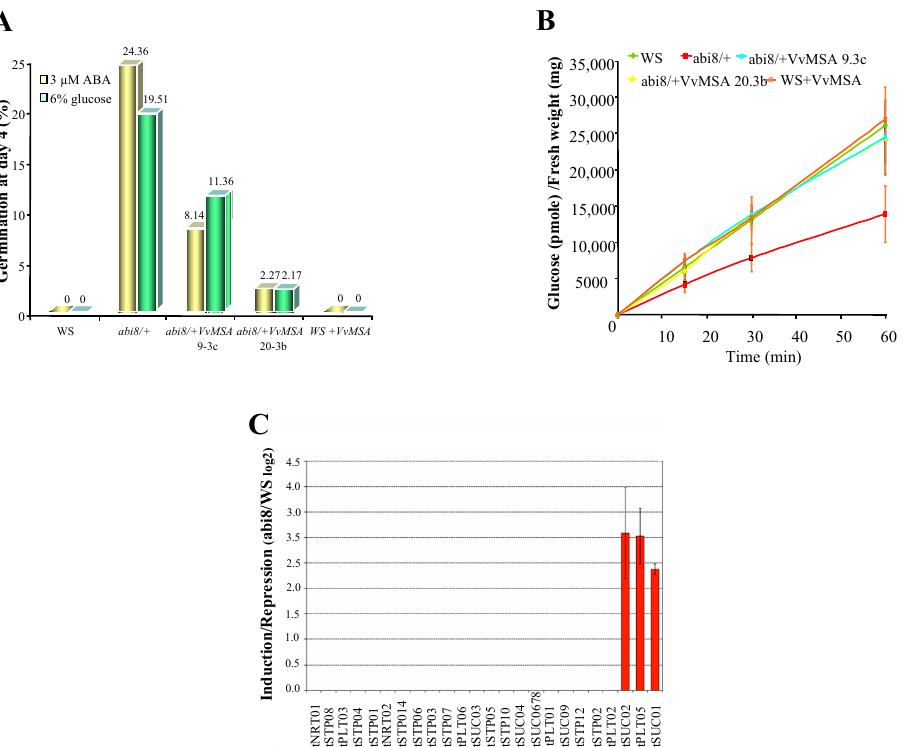
risk of post-transcriptional gene silencing by co-suppression. Two different abi mutants, affecting the APETALA2 transcription factor ABI4, and ABI8 encoding a protein of unknown function, were transformed with p35S::VvMSA . While abi4 exists as a homozygous mutant, abi8 is a seedling lethal and must be maintained as a heterozygote [72,73]. Several homozygous VvMSA-overexpressing lines, T3 and T4 generations, were obtained for both abi4 and abi8 mutants. Although transformed abi4 + VvMSA enhanced its germination resistance to ABA and glucose (Figure S9), the overexpression of VvMSA partially restored the germina- eventual cotyledon greening (Figure S10).